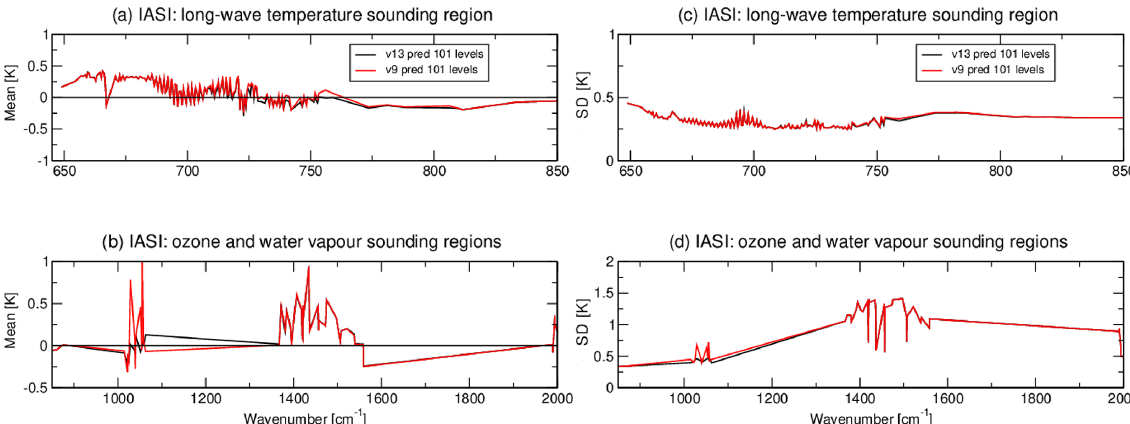
Figure 16. As Fig. 14 but with RTTOV v13 coefficients that are based on the new v13 predictors with all seven variable gases and the v9 predictors with six variable gases (all gases except SO 2